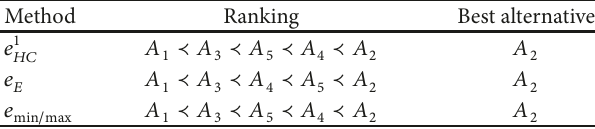
Table 16: Ranking of alternative for different